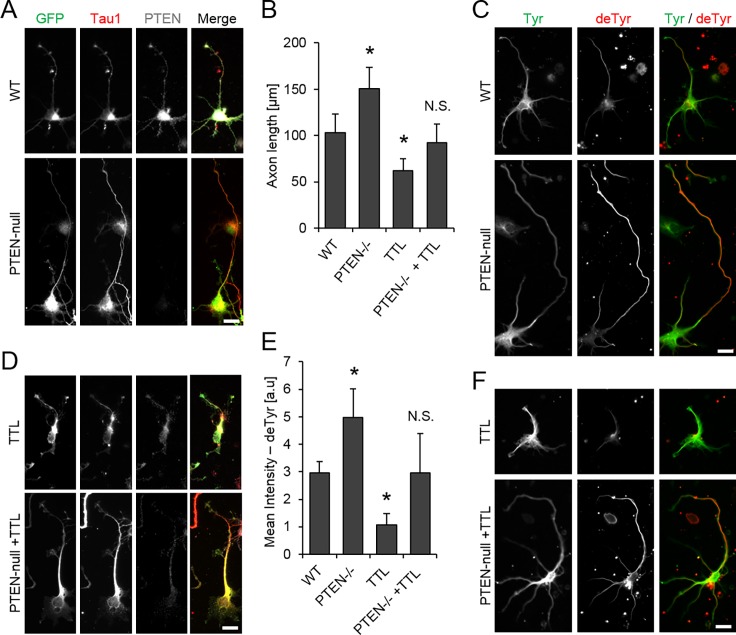
Detyrosination of microtubules and axon length is enhanced by loss of PTEN in neurons.Hippocampal neurons isolated from PTENflox/flox E16 mice were transfected with RFP-IRES-Cre (PTEN-null) and/or GFP-tubulin tyrosine ligase (TTL) at DIV 0, seeded on PLL coated coverslips and fixed at DIV 3. [A, D] Representative images of neurons immunostained against GFP (green), Tau1 (red) and PTEN (grey). Scale bar, 20 μm. [B] Quantification of axon length. Error bar = StdDev, N = 4 (total of >100 cells each). [C, F] Representative images of neurons immunostained against detyrosinated- (red) and tyrosinated- (green) tubulin. [E] Mean intensity of the detyrosination signal in RFP (PTEN-null) or GFP positive (GFP-TTL) neurons. Error bar = StdDev, N = 5 (total of >100 cells each). Scale bars, 20 μm, * p<0.05.